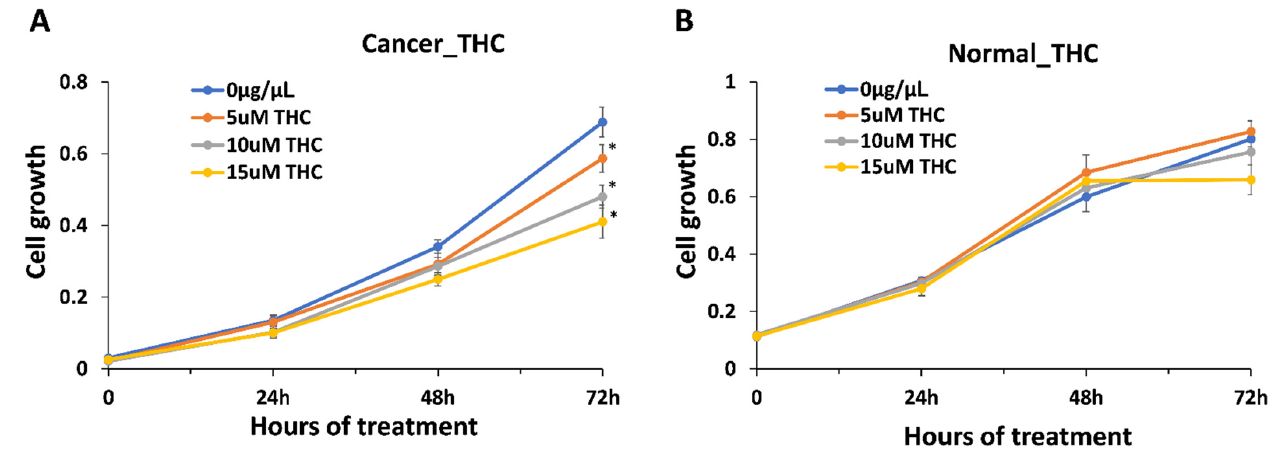
Figure 3. Inhibition of growth of breast cancer cell line HCC1806 and normal cell line BJ-5ta in response to THC. ( A )— growth curve of HCC1806 cells in response to 5, 10 and 15 uM of THC; ( B )—growth curve of BJ-5ta cells in response to 5, 10 and 15 uM of THC. Y axis shows arbitrary units of cell growth, while X axis shows the time of treatment. MTT assay was performed and data were expressed as an average (from 3 independent replicates) with SD. Asterisks indicate signif- icant ( p < 0.05) difference from control (0